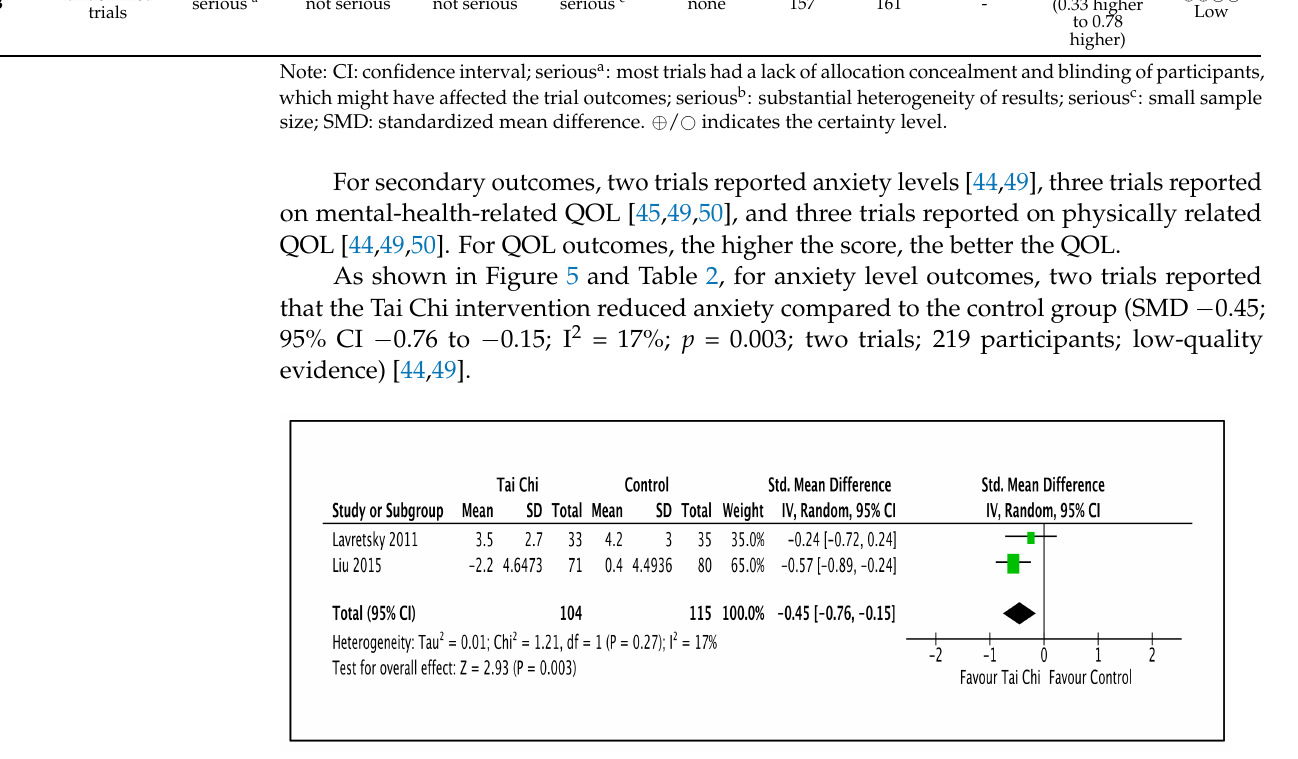
Figure 5. Forest plot provided for comparison of the combination of Tai Chi and antidepressants versus standard antidepressants for anxiety level outcome [44,49]. Note: Line indicates confidence interval and the green square indicates effect estimate. Black diamond indicates cumulative effect and its confidence